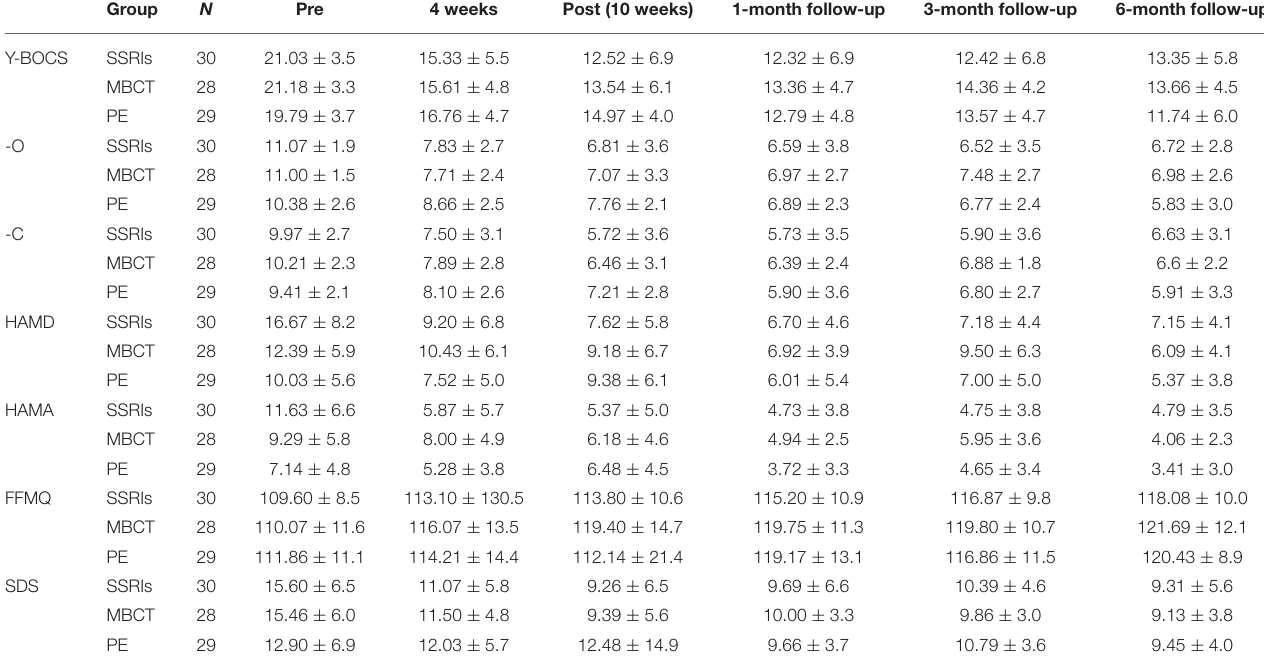
TABLE 3 | Results of descriptive statistics by condition (mean ± SD).